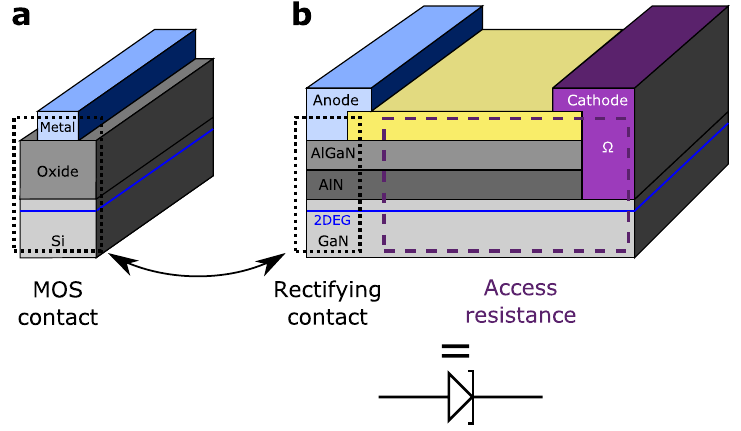
Figure 1. MOS analogy. ( a ) Typical MOS contact as found in a Silicon MOS capacitor. ( b ) AlGaN/AlN/GaN diode half cell separated into two main components: the rectifying contact and the access